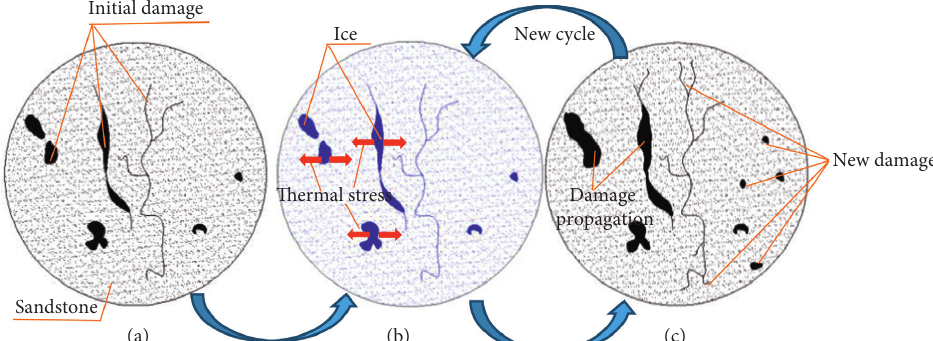
Figure 12: Conceptual model of the freeze-thaw deterioration process. (a) Initial damage; (b) volumetric expansion after the water has frozen; (c) damage